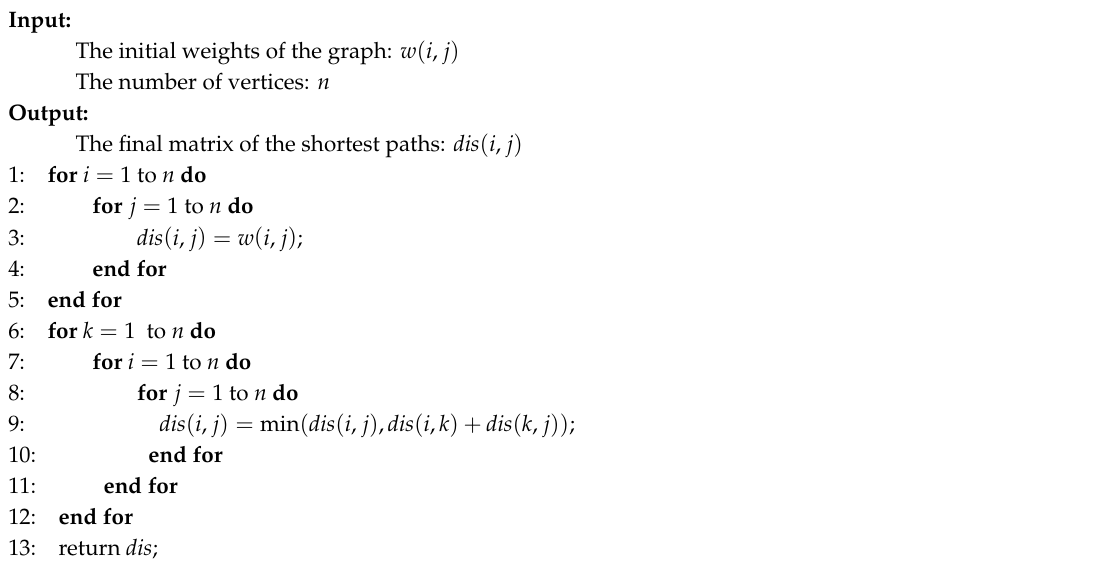
Algorithm 1 The Floyd-Warshall’s shortest path algorithm